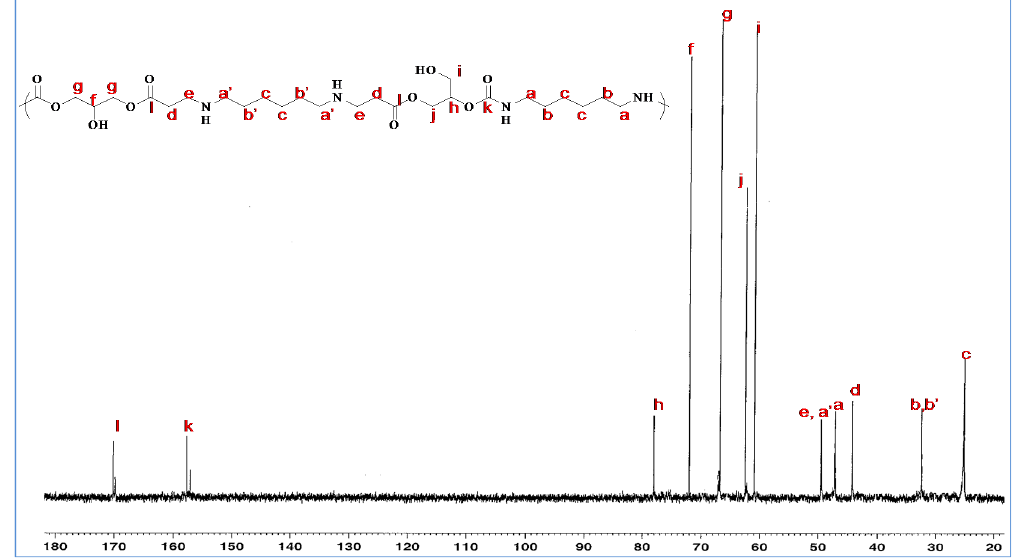
Figure 7. zgig 13 C-NMR spectrum for a glycerol amino ester ethylene PHUs in D 2 O.